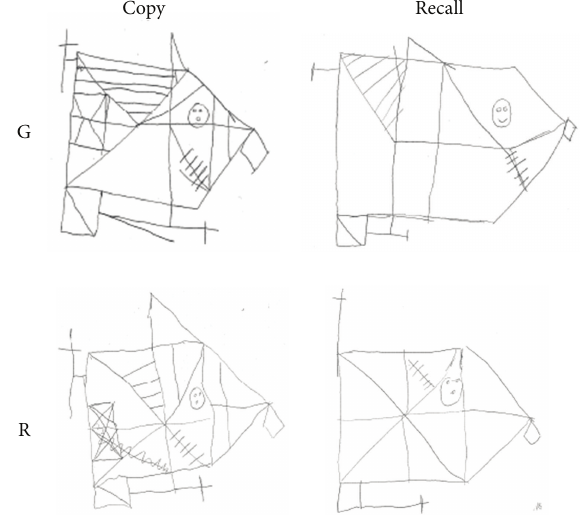
Figure 6: Rey’s figure: Copy and Recall performed by G. and R. at follow up. A relevant improvement was observed in their drawings, both in the details and in their into a global shape, compared to the first assessment.